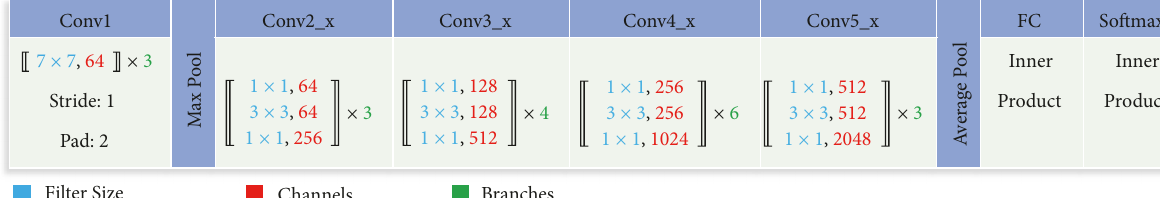
Figure 3: Architecture of 50-layer residual CNN model, which is changed for 128 × 128 face images. Conv3 1, Conv4 1, and Conv5 1 are down sampled using max pooling with stride of 2.